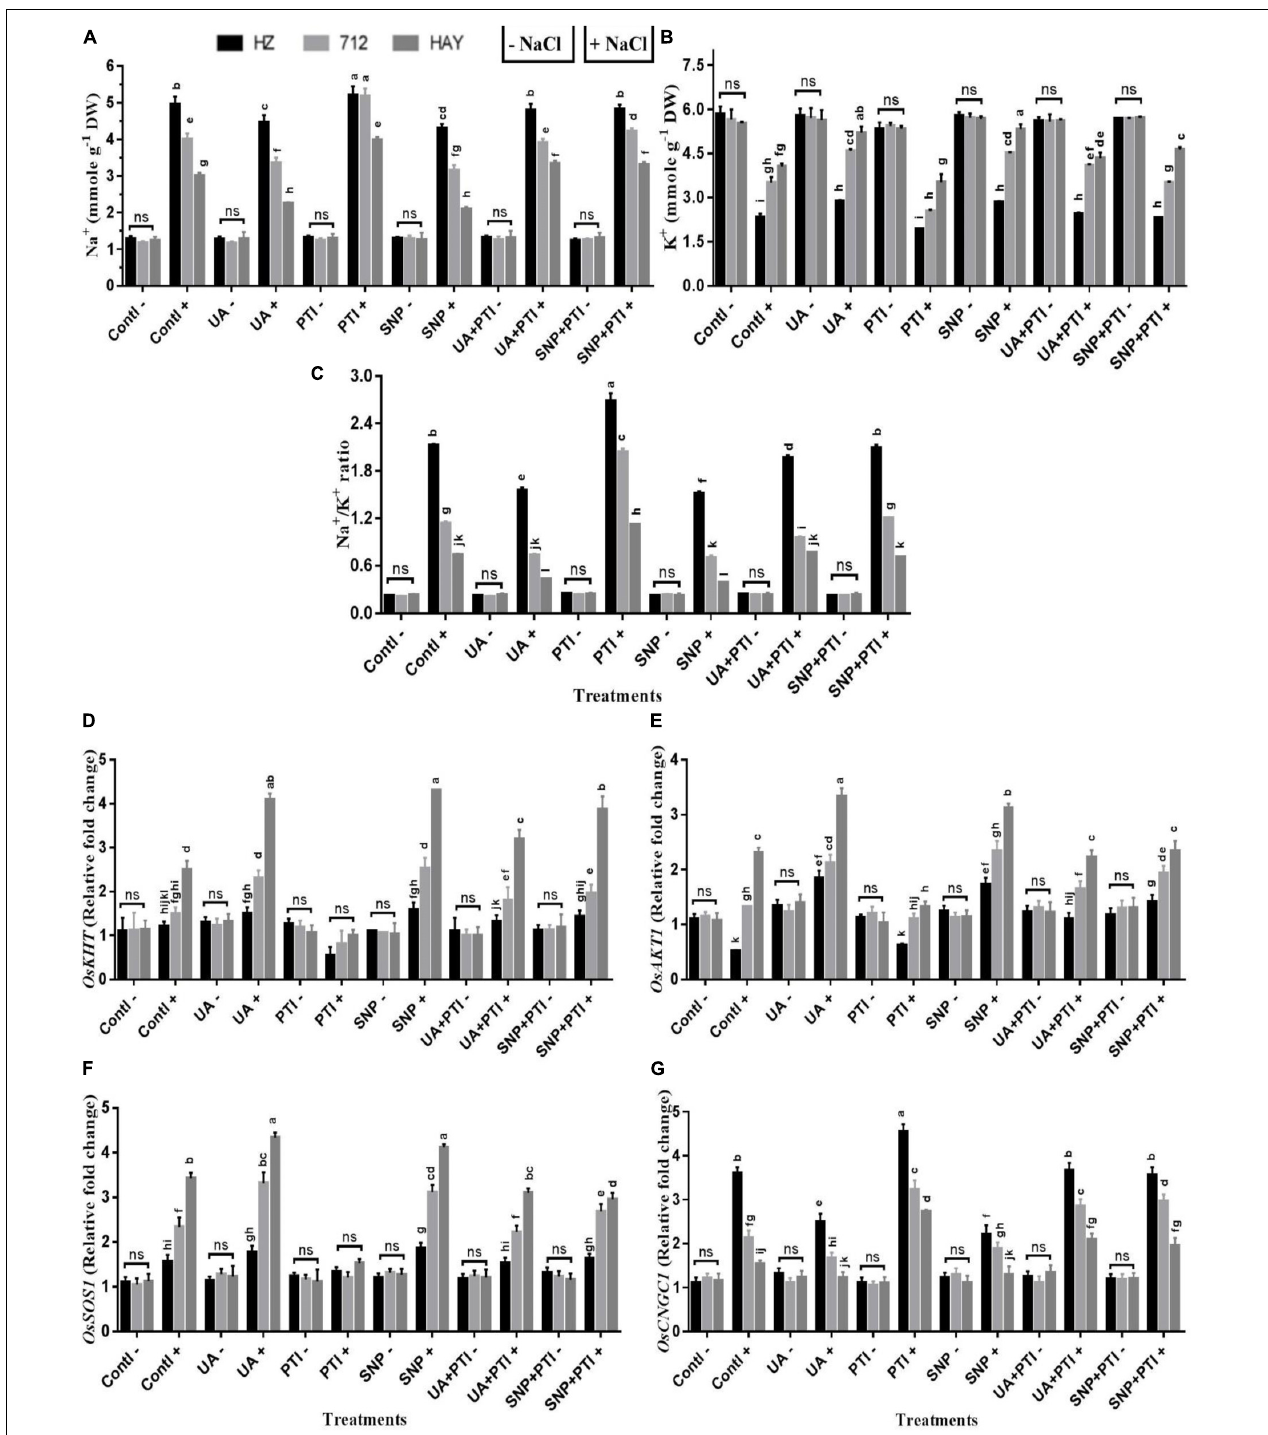
FIGURE 7 | The pharmacological experiments shows that Ursolic acid (UA) modulated ion homeostasis (Na + and K + ) via NO production in salt stress rice cultivars (A–C) . Transcript profiling indicated that activation of Na + and K + transporters and SOS signaling pathway were regulated by UA via NO production in leaves of salt stress cultivars (D–G) . Fourteen-day-old rice plants were pretreated with 100 µ M UA, 10 µ M SNP, 100 µ M PTI alone or their combinations for a day, and then transferred to 8 dS m − 1 for another seven days. Means with the same letters are not significantly different based on three-way ANOVA followed by Duncan’s test ( P ≤ 0.05) for each cultivar at different salt stress treatments. The results are shown the mean ± SE of five replicates and three/four plants were bulked for each replicate. UA = ursolic acid, PTI = 2-(4-carboxyphenyl)-4,4,5,5-159 tetramethylimidazoline1-oxyl-3-oxide potassium salt, SNP = sodium nitroprusside. “ − ” NaCl absent, “ + ” NaCl present, ns: not statistically significant ( p > 0.05). Three-way interaction of factors is presented in Supplementary Table 2